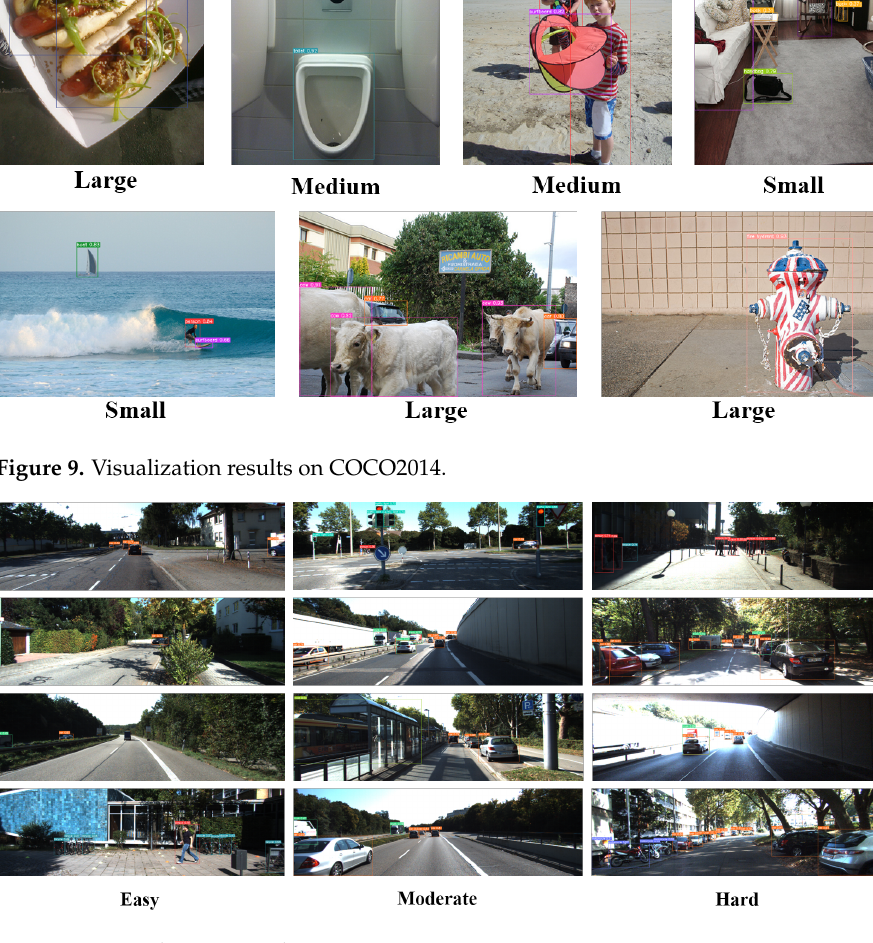
Figure 10. Visualization results on KITTI.